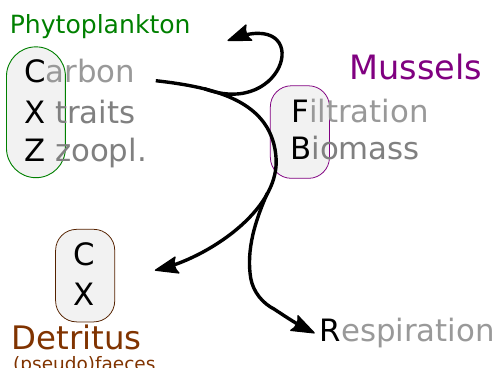
Figure 2. Schematic representation of the filtration model considering the conversion and flow of compartments, elements, and related quantities. Direct excretion of dissolved nutrients was not considered in this study.